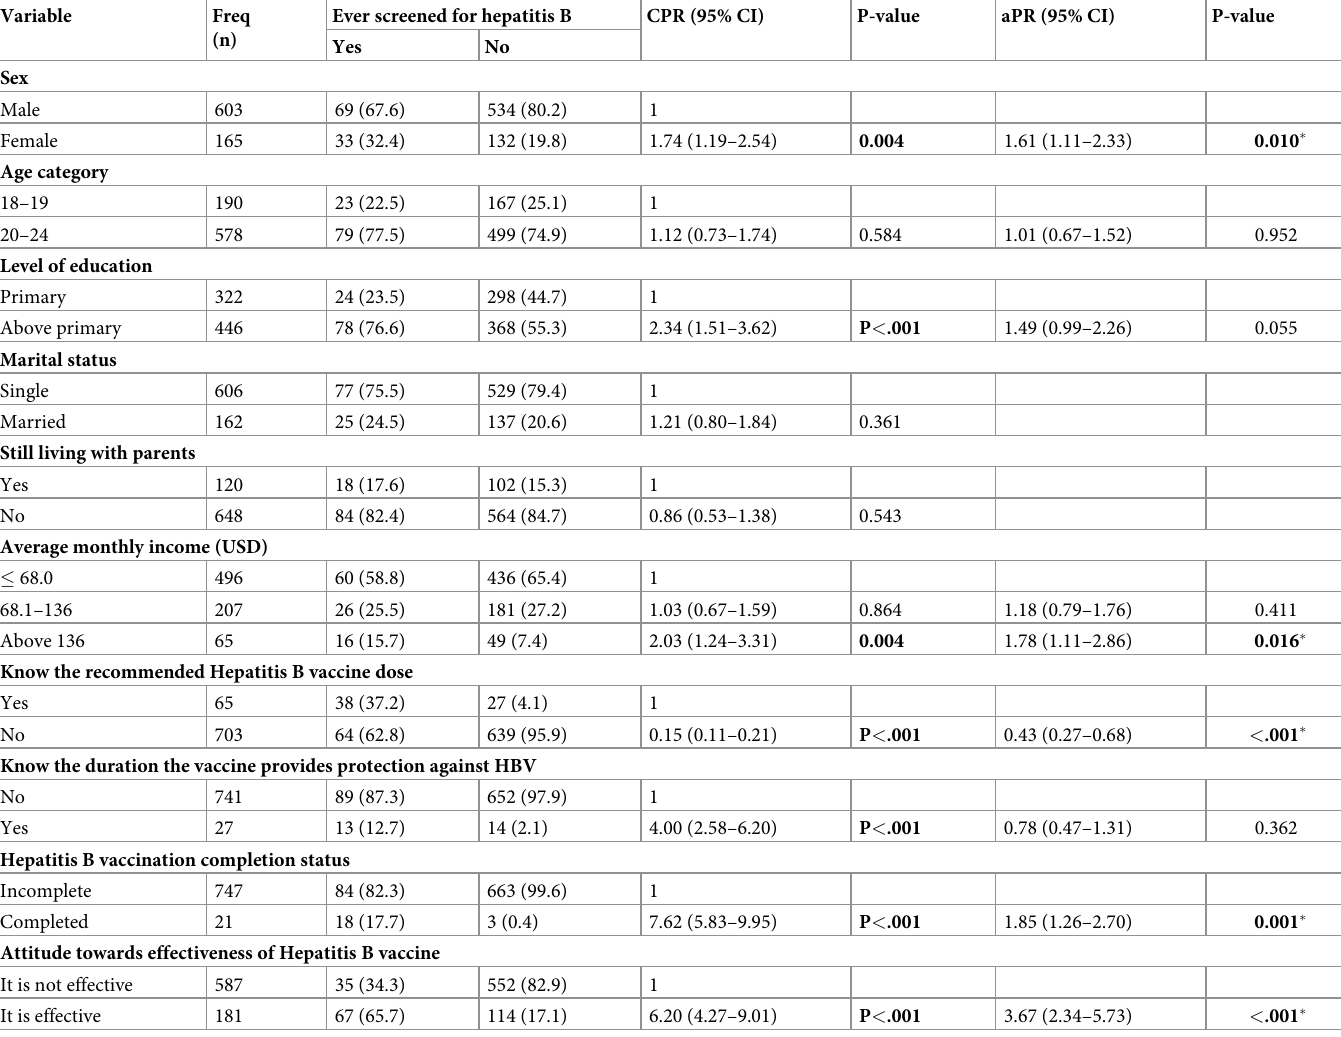
Table 2. Predictors of “ever screening for hepatitis B” among young psychoactive substance users in informal settlements in Kampala